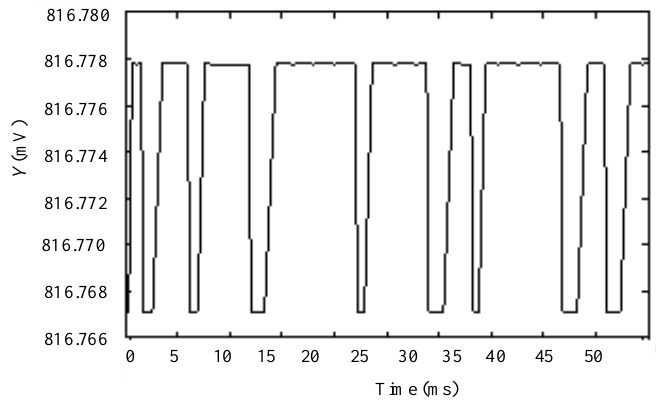
Figure 2. Noise source circuit transient simulation waveform.